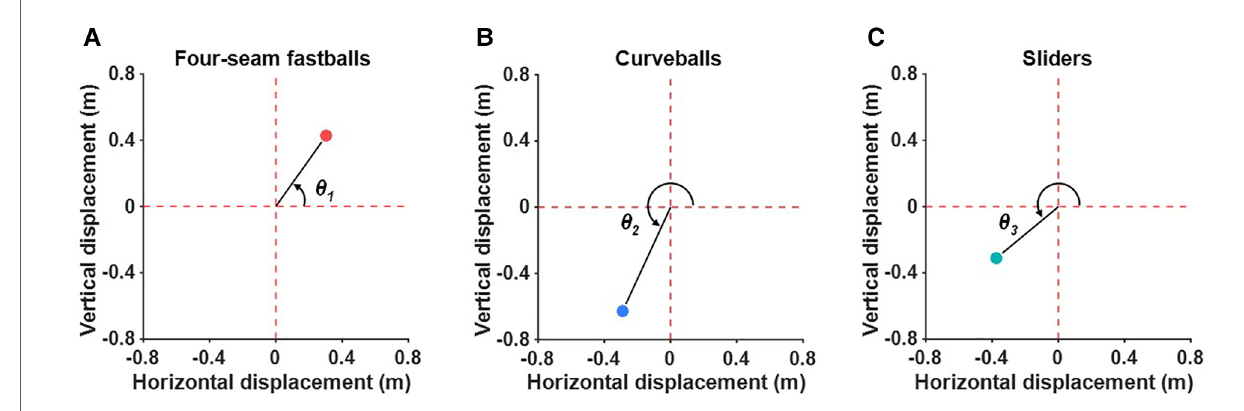
FIGURE 1 De fi nition of the angle of each pitch type in the horizontal and vertical displacement plane. The angle between the horizontal displacement axis and the line connecting the origin and the deviation of the four-seam fastballs is de fi ned as θ 1 ( A ). θ 2 and θ 3 are de fi ned as the angle between the horizontal displacement axis and the line connecting the origin and curveballs ( B ) and sliders ( C ),